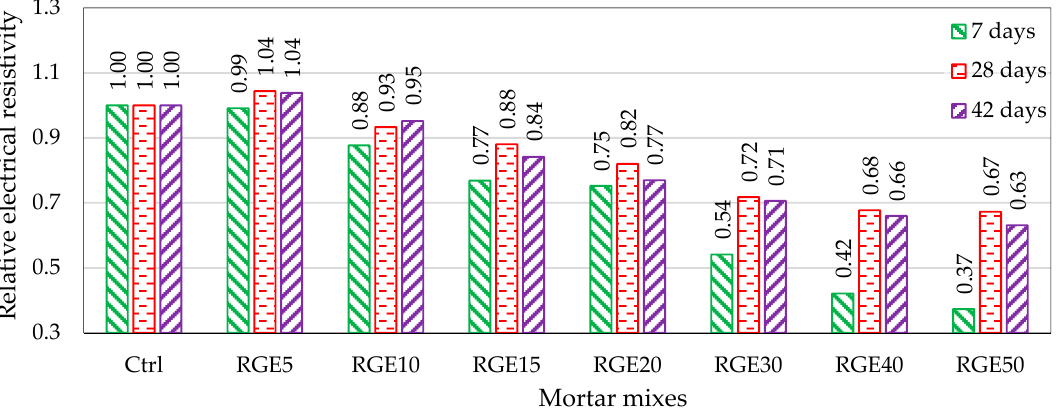
Figure 15. Relative electrical resistivity at the ages of 7, 28, and 42 days.